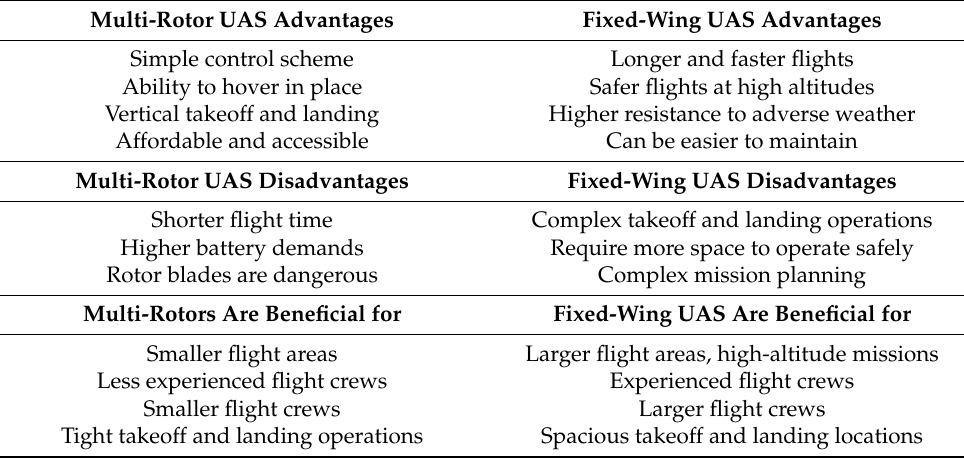
Table 1. Comparative assessment of the multi-rotor and fixed-wing aircraft